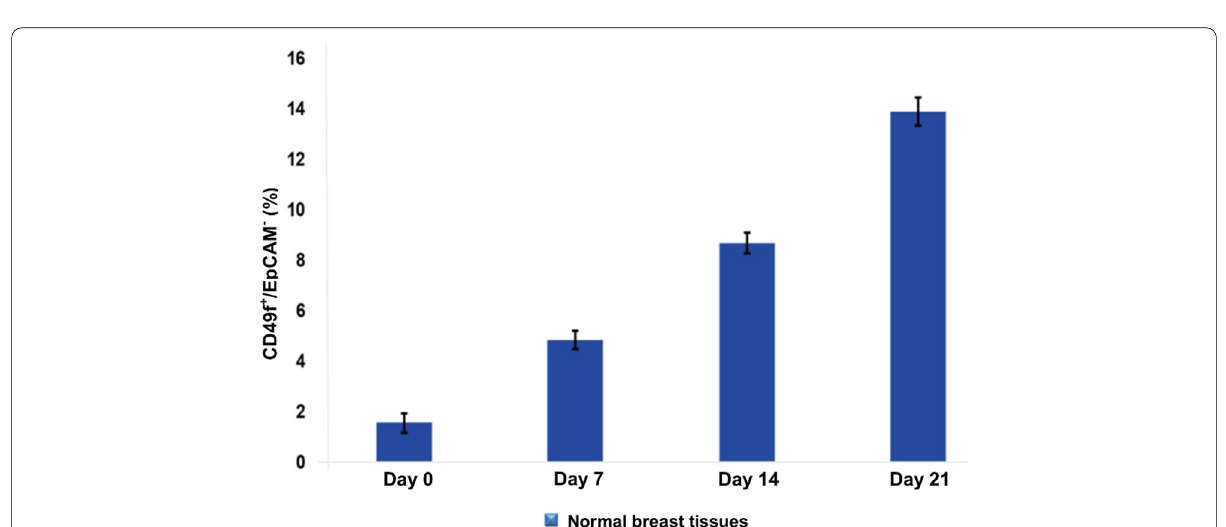
Fig. 7 Proportions of normal mammary stem-like cells with CD49f + /EpCAM − /low phenotype from normal breast tissue on day 7, 14, and 21